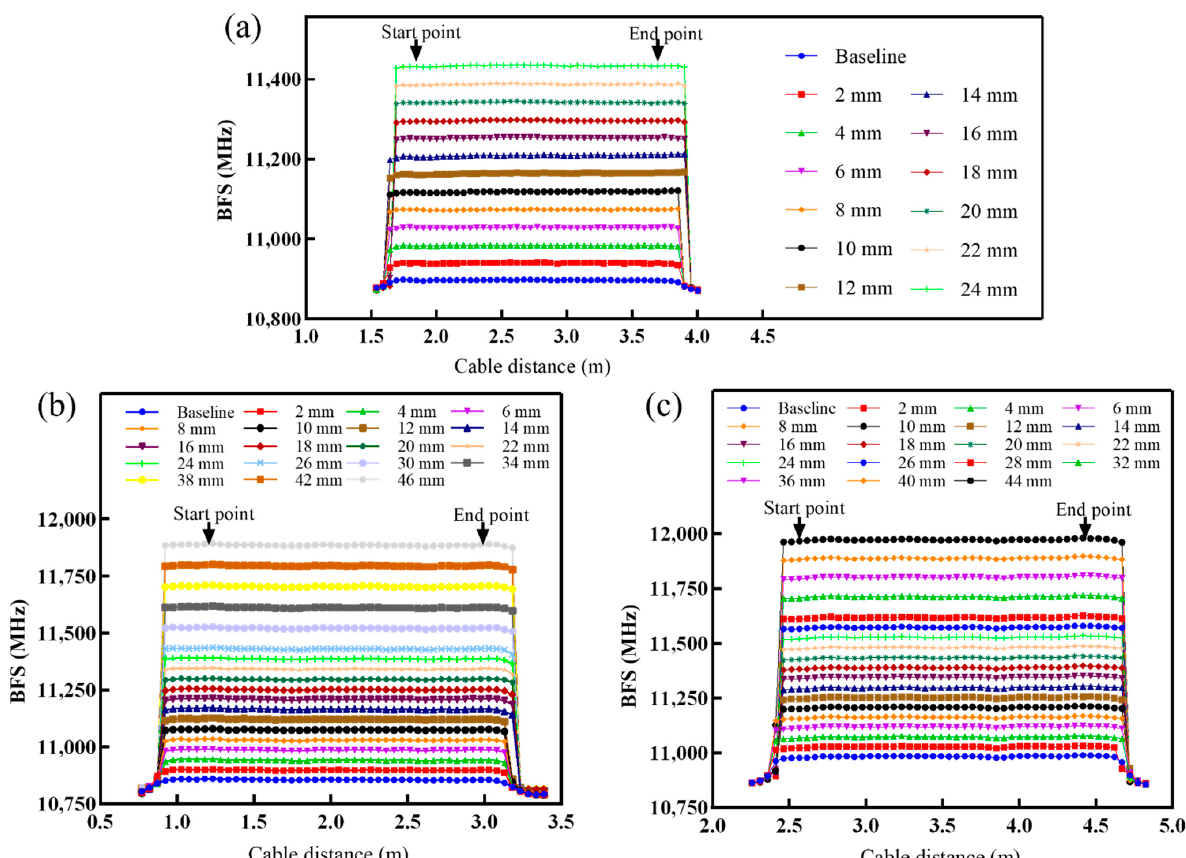
Figure 7. Brillouin frequency distribution along the sensing cable in different calibration stages: ( a ) sensing cable A, ( b ) sensing cable B, ( c ) sensing cable C.